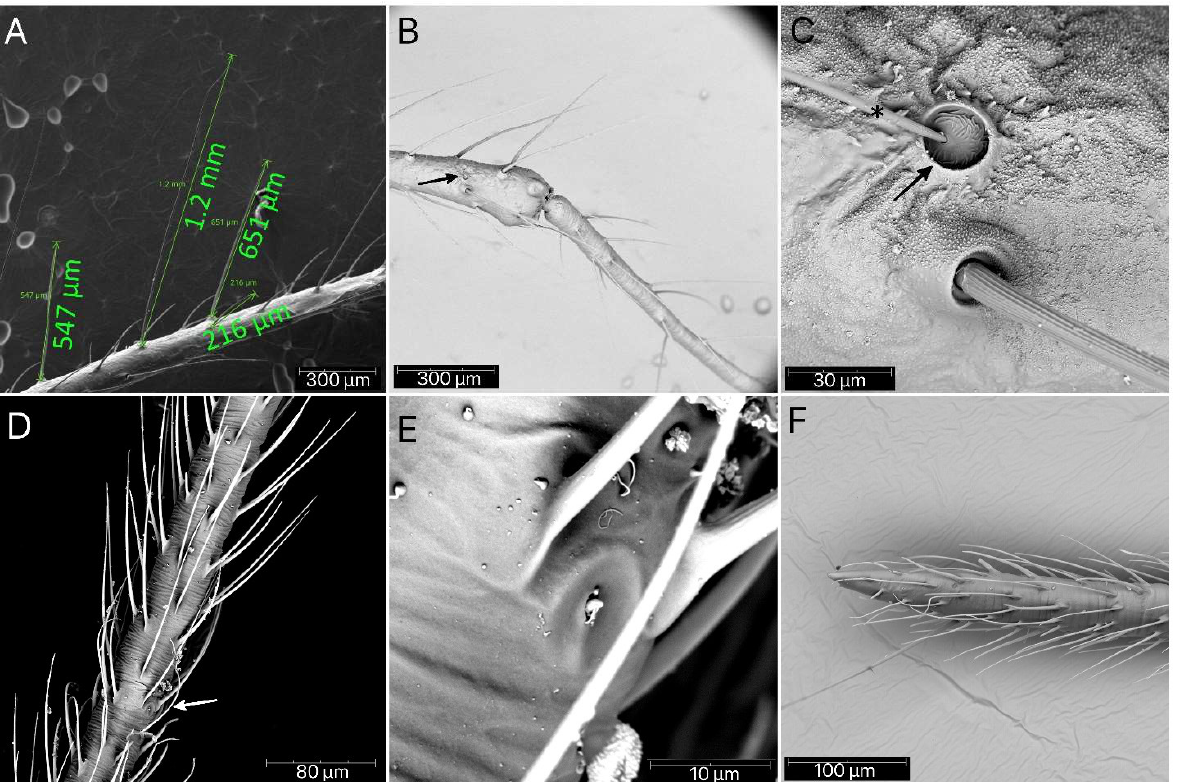
Figure 18. Psyttala horrida (Stål, 1865), antennae. ( A ) Setae of different lengths on the basiflagellomere; ( B ) the end part of the pedicel with a single trichobothrium , and ( C ) magnification of the antennal trichobothrium (mechanoreceptive seta [ * ] situated in a depression in the cuticle [arrow]); ( D ) the central part of the distiflagellomere with densely arranged setae and ( E ) single sensillum coeloconicum ; ( F ) apical part of the distiflagellomere.